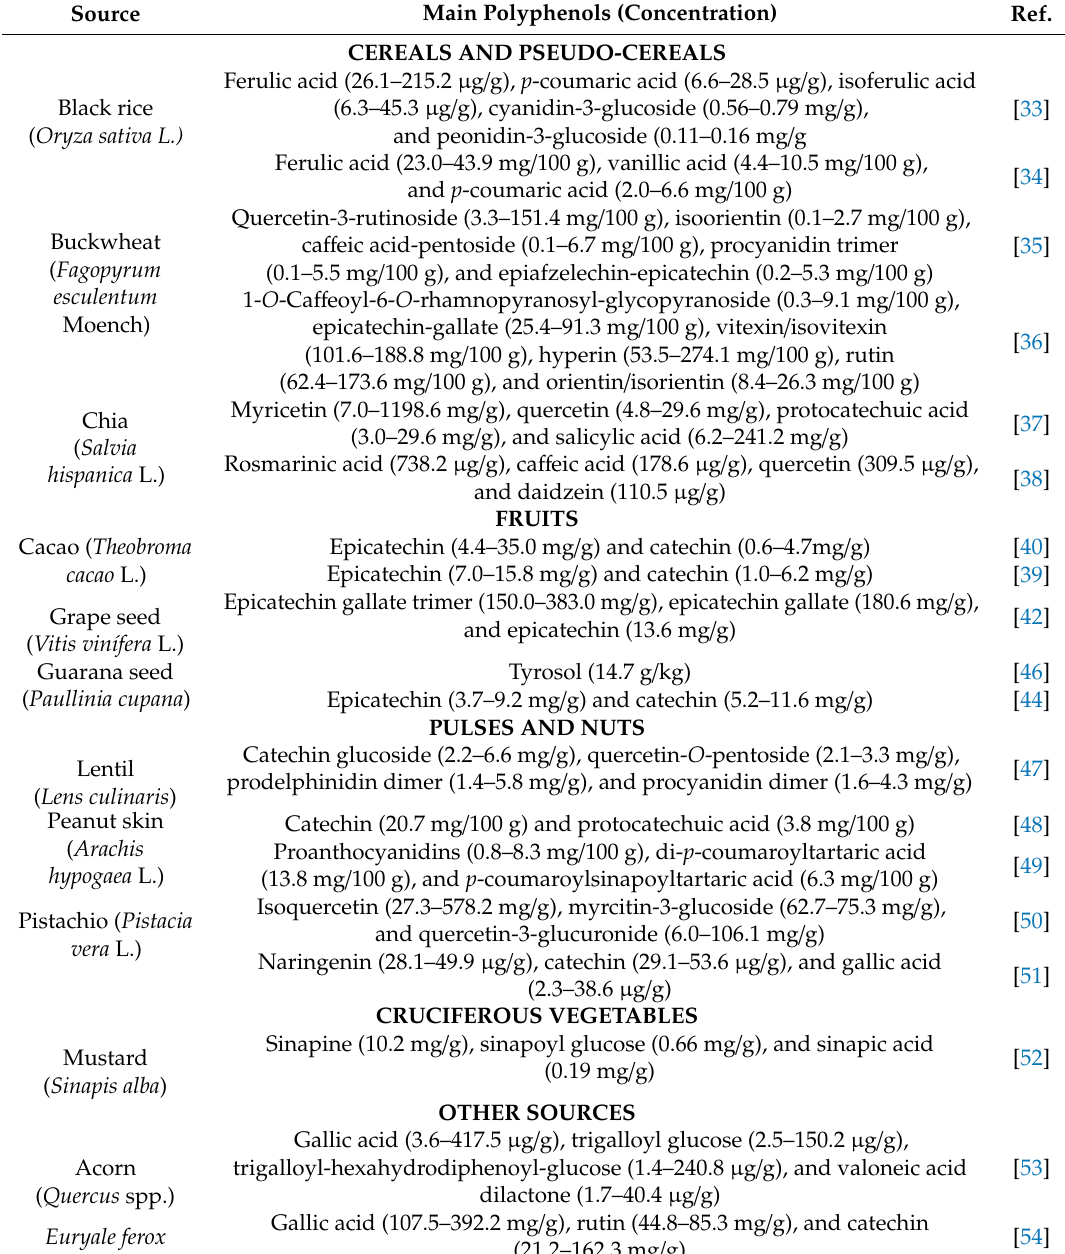
Table 1. Main phenolic compounds found in selected